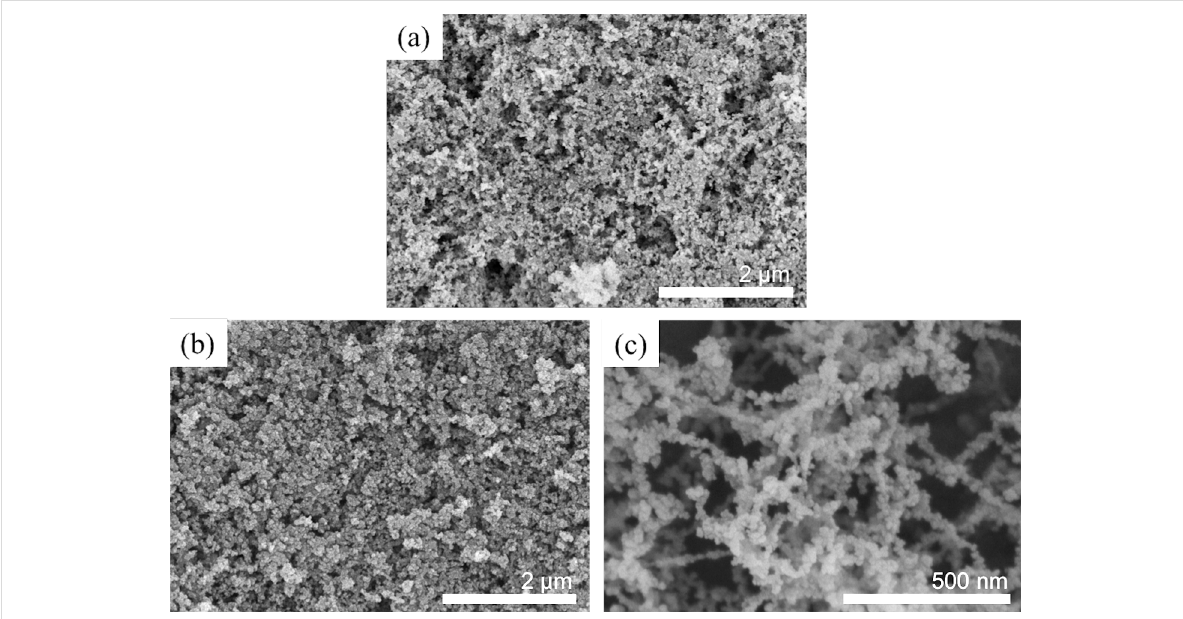
Figure 2: Typical top-down-view SEM images of sample surfaces: (a) Never Wet, (b) VUV-Never Wet, and (c) Soot-TMOS-FAS17Cl.